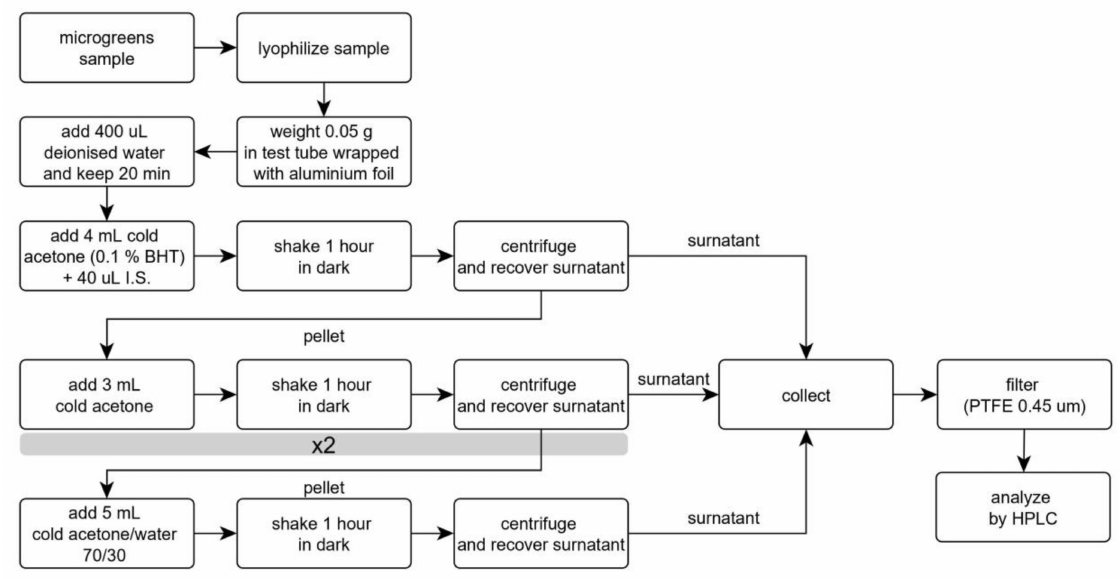
Figure 5. Flowchart of the extraction protocol for the analysis of carotenoids in microgreens. A typical chromatographic separation is reported in Figure 6.